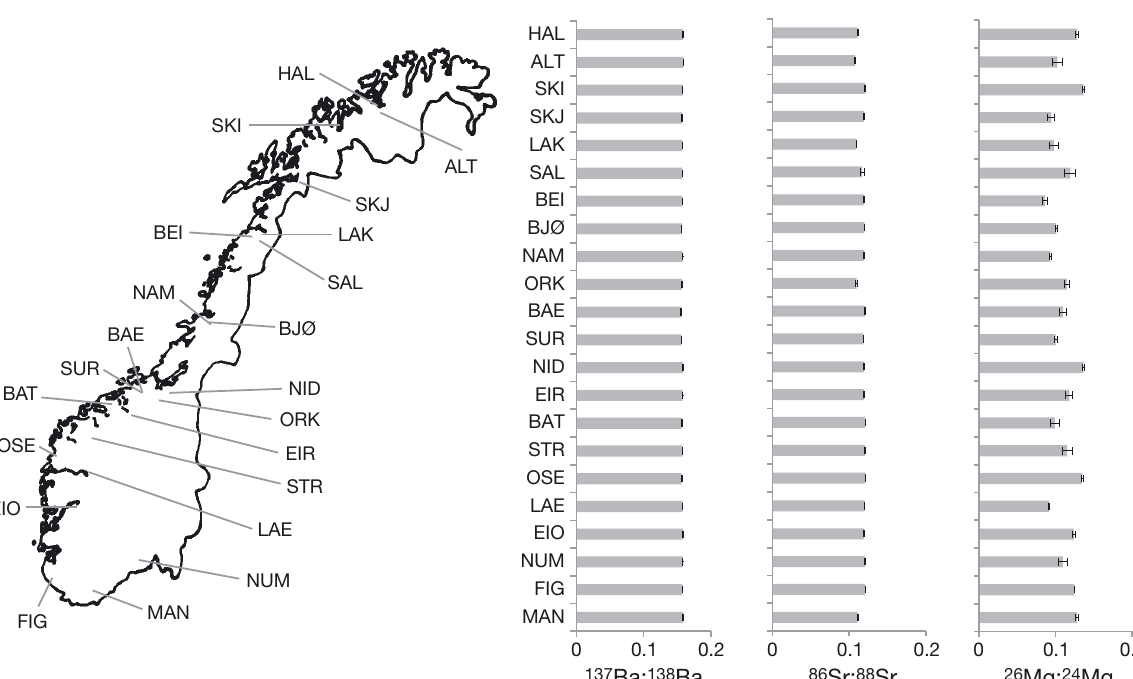
Fig. 6. Baseline isotope ratios of Norwegian Salmo salar parr surveyed from 22 rivers across Norway. Bars represent the average ratios of 3 fish from each river sampled, except for Saltdalselva (SAL) and Strynselva (STR), where bars represent the average ratios of 18 fish sampled between 1990 and 2010. Error bars represent ±1 SE. See Table A1 in the Appendix for